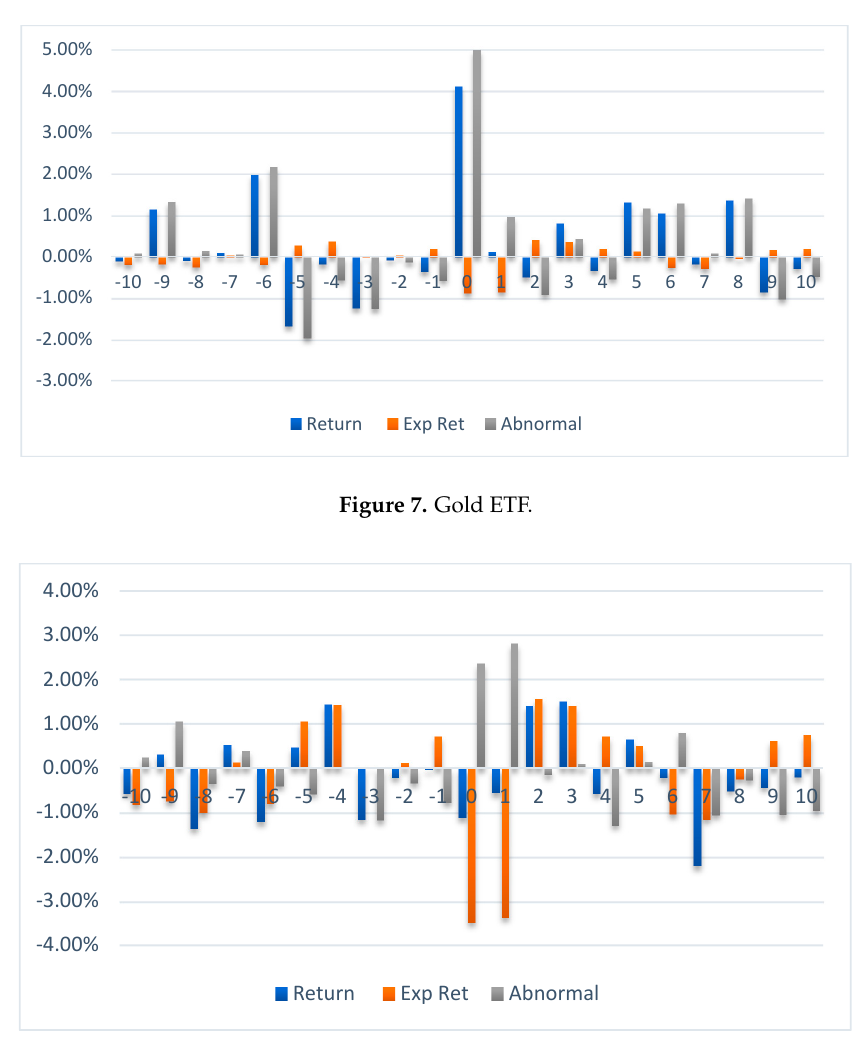
Figure 8. Oil ETF.